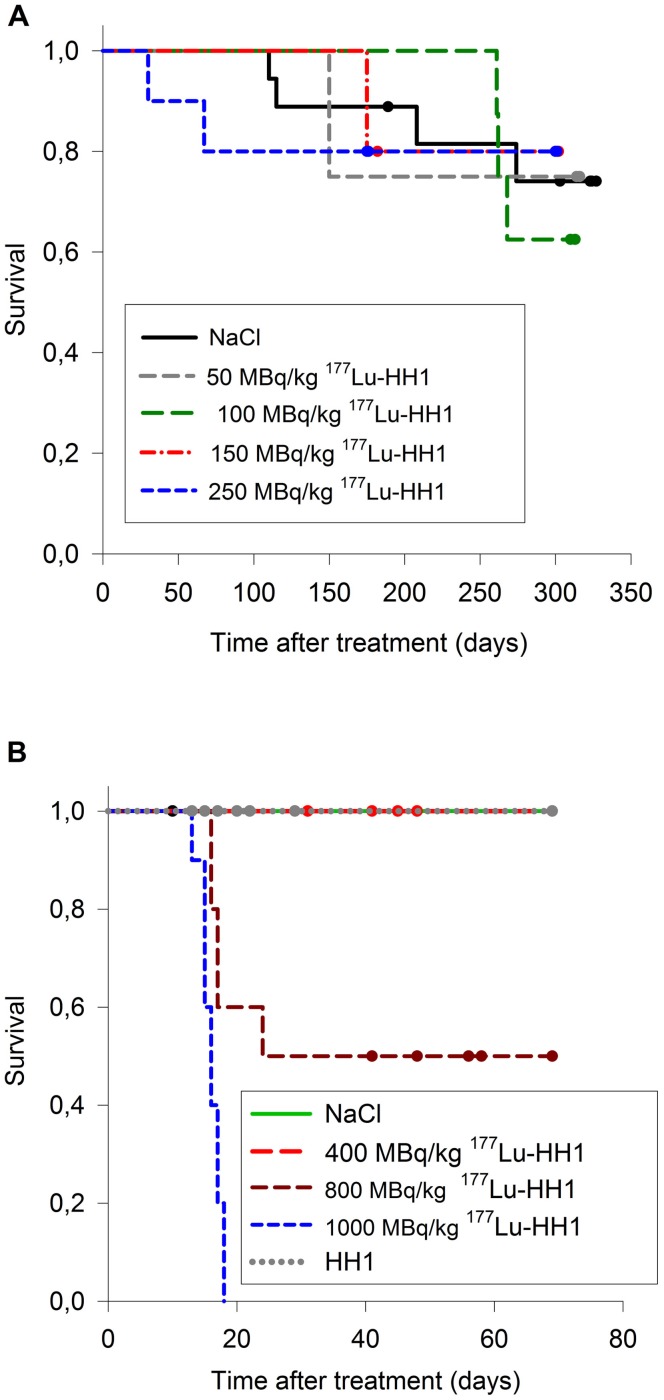
Survival of mice treated with increasing dosages of 177Lu-HH1.
A. Mice without xenografts treated with saline or 50, 100, 150 or 250 MBq/kg 177Lu-HH1 (experiments 1 and 2). The end point for survival was euthanasia due to weight loss or substantial discomfort. B. Mice with Ramos xenografts treated with saline or 400, 800 or 1000 MBq/kg 177Lu-HH1 (experiment 4). The end point for survival was euthanasia due to WBC<1.5 109 cells/L (usually accompanied by RBC<5 1012 and PLT<400 109 cells/L), weight loss higher than 15% from base line, and/or substantial discomfort, all symptoms associated with radiation toxicity. Mice euthanized because of tumor diameter larger than 20 mm were censored.